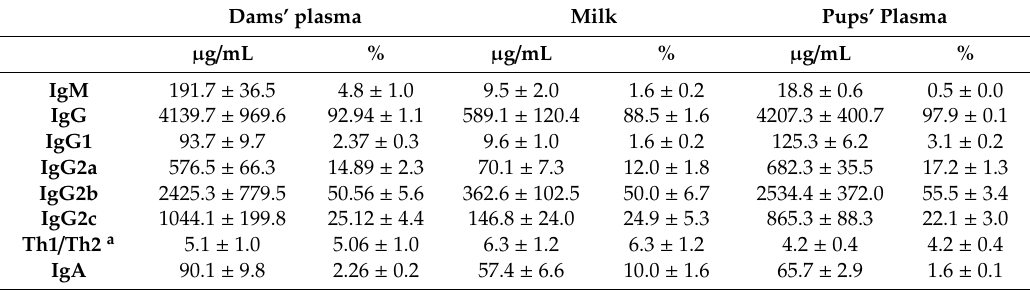
Table 2. Analysis of absolute and relative Ig concentration in milk and plasma of dams and pups. Dams’ plasma